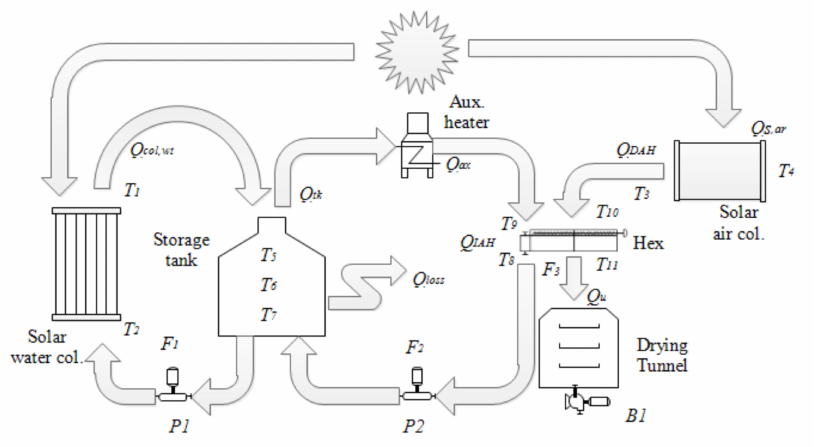
Figure 1. Solar hybrid air heating